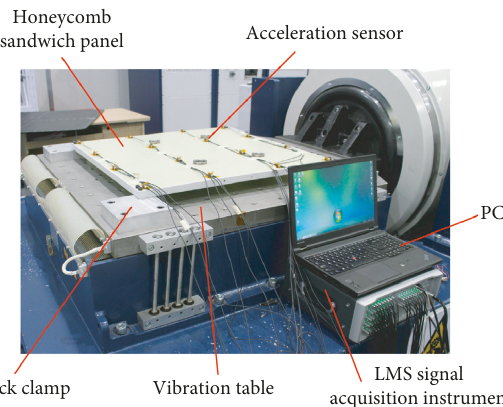
Figure 4: Modal test setup of satellite sailboard.